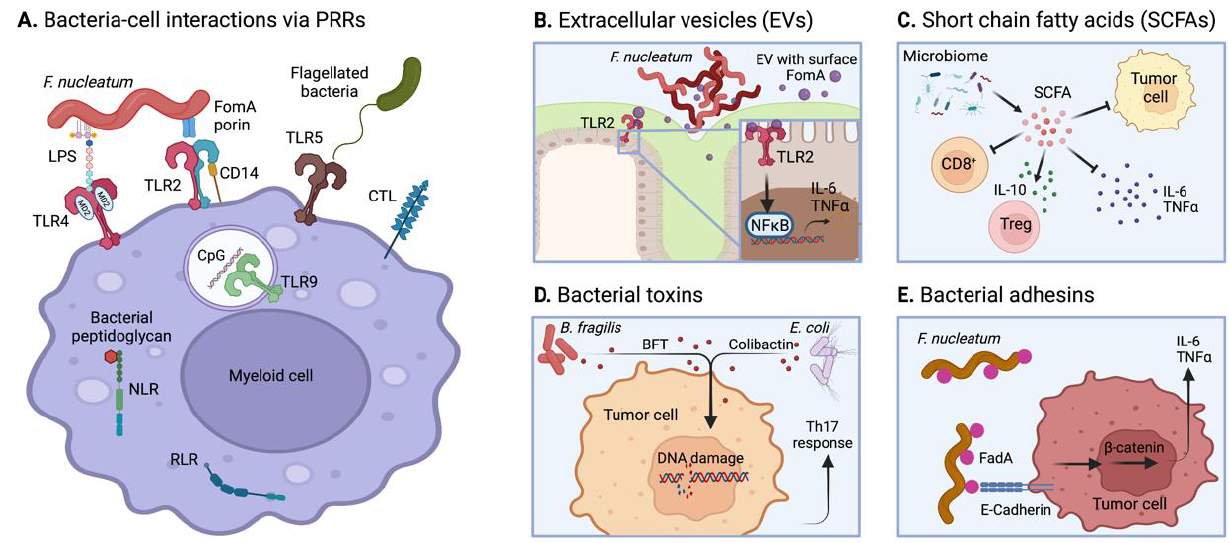
Figure 7. Examples of tumor immunomodulation by microbiome-cell interactions. ( A ) Activation of immune cells by PRR stimulation upon detection of bacterial-derived components. ( B ) Activation of PRR by bacterial-derived EVs and subsequent cytokine secretion. ( C ) Immunomodulation by SCFAs produced upon bacterial fermentation. ( D ) Indirect immunomodulation by bacterial toxins. ( E ) Induction of cytokine production upon bacteria adhesion on cell surface.